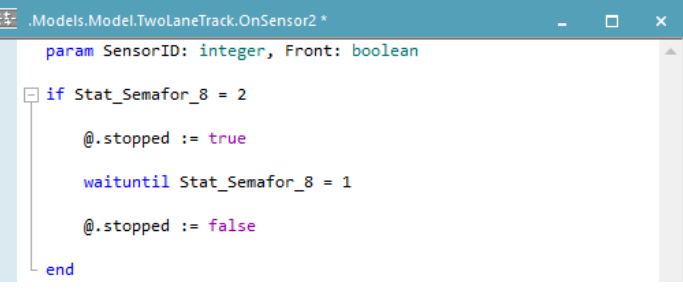
Figure 10. Connector method for stopping and starting a pedestrian on TLS.